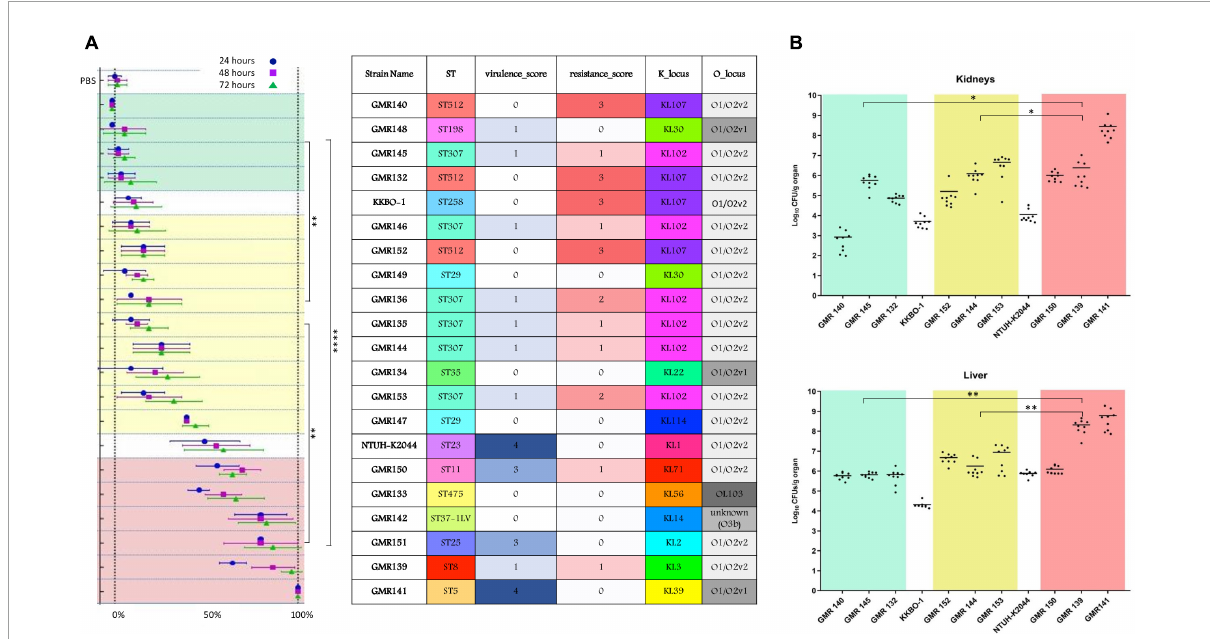
FIGURE3 Summary of most relevant features of studied strains (ST, virulence score, resistance score, K type and O type) and results obtained in the animal infection models. (A) Results of experiments in the G. mellonella model expressed as mortality rate (percentage of dead over the total of inoculated larvae). Means and SD of three replicate experiments are show at different time points for each strain (after 24, 48, and 72 h). (B) Results of virulence experiments, for representative HMV isolates, in the murine model expressed as Log10CFU/g organ of the studied strains, recovered from kidneys and livers. Each dot represents data obtained from one mouse specimen and the solid line represents the mean value. In both the models, the NTUH-K2044 virulent strain and the KKBO-1 low-virulence strain were included and used as reference for classification of studied isolates in three different virulence categories: low (green zone), intermediate (yellow) and high (red). Mortality rate at 72 h (A) and Log10 counts (B) for the three groups were compared. P -values < 0.05 were considered significant; ∗ < 0.05, ∗∗ < 0.005, ∗∗∗∗ <